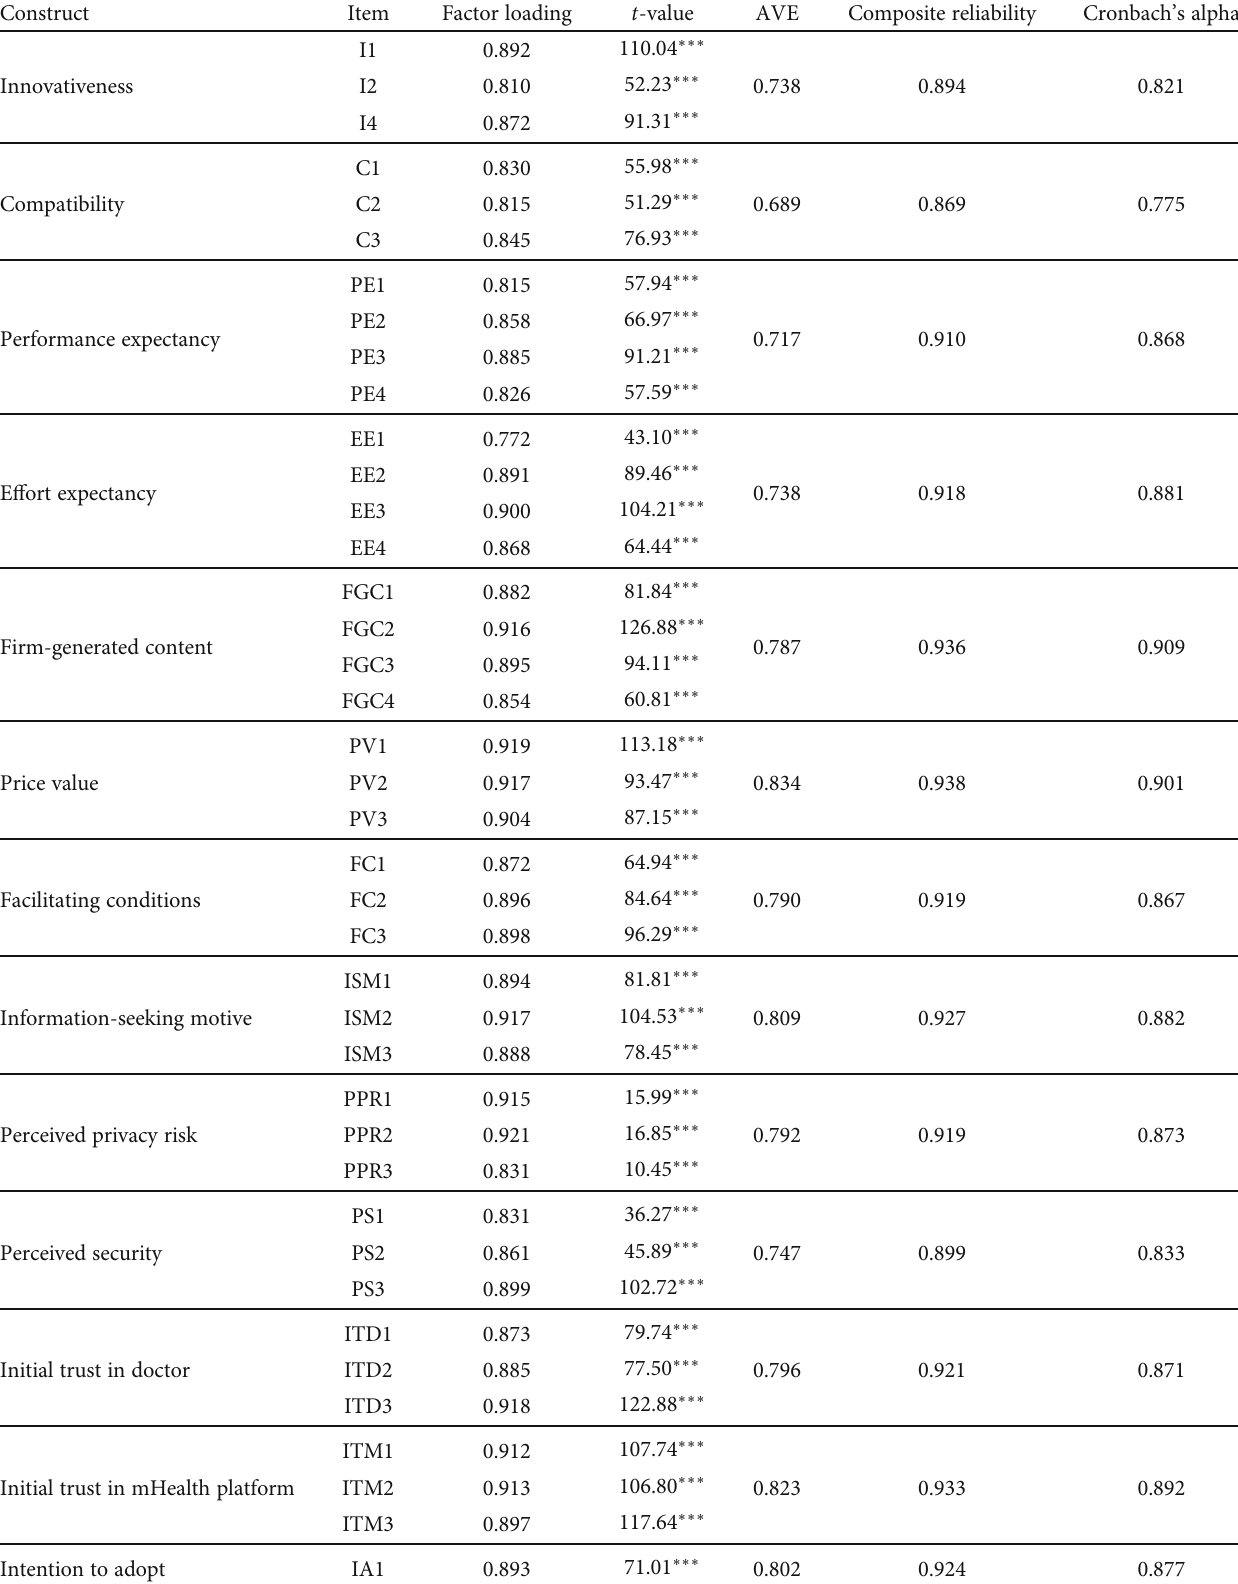
Table 9: Measurement models and factor